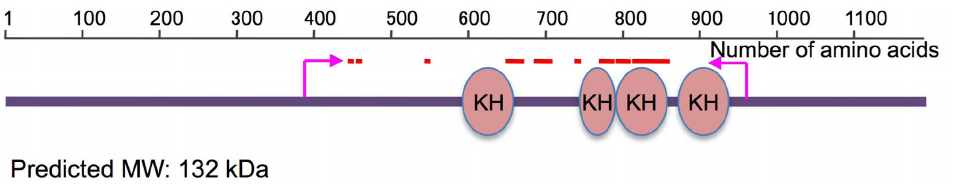
Figure 4. The predicted structure of the verified PREBP, PF3D7_1011800. Domains within the PF3D7_1011800 protein predicted from its amino acids sequence. The peptides detected in mass spectrometry are indicated with red bars. The predicted K-homology (KH) domains are indicated with circles. The start and end points of the partial , 60 kDa recombinant protein, which is expressed in the transgenic parasite, are indicated as arrows.